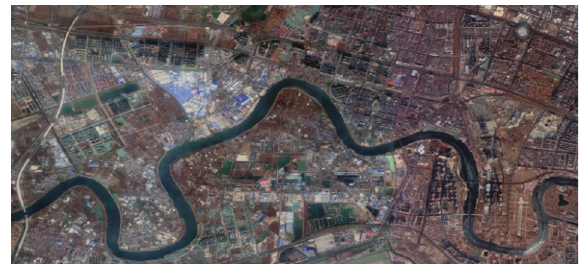
Figure 2: Satellite map of Haihe River in Tianjin,